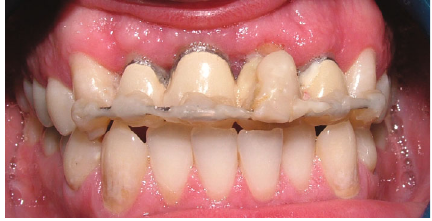
Figure 15: Extrusion with 19-gauge stainless steel arch wire.